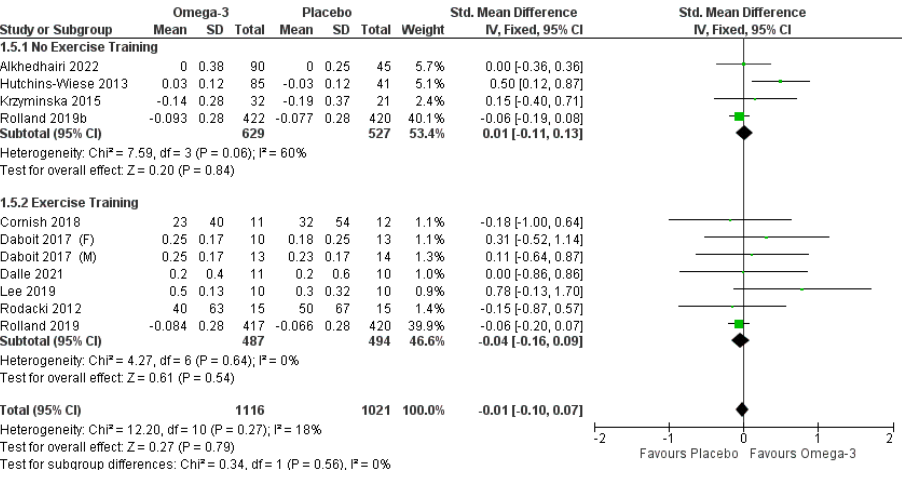
Figure 7. Pooled analysis of the impact of omega-3 supplementation on walking